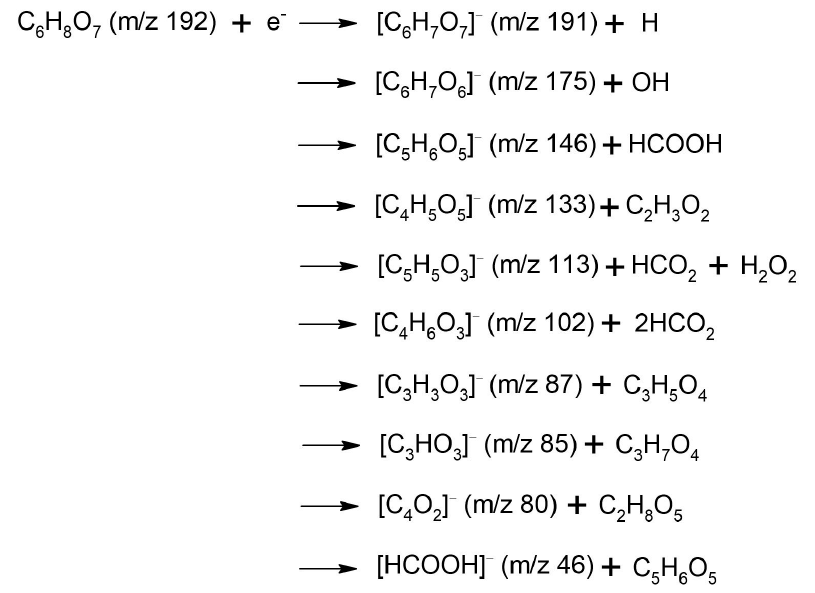
Scheme 2. Fragmentation reactions of citric acid upon interaction with low-energy electrons. Table 2. Calculated fragmentation thresholds (DFT level of theory) of cis-enol oxaloacetic (OA) and citric (CA) acids: enthalphy (0 K) and Gibbs free energy at the ω B97x/aug-cc-pvtz level at 400 K. Energies in eV. * Values for trans-enol OAA are given in parentheses. The values in red are Gibbs free energies calculated at 298 K. M = OAA * M = CA Gibbs Free Gibbs Free Enthalpy Enthalpy Energy Energy [M-H] -